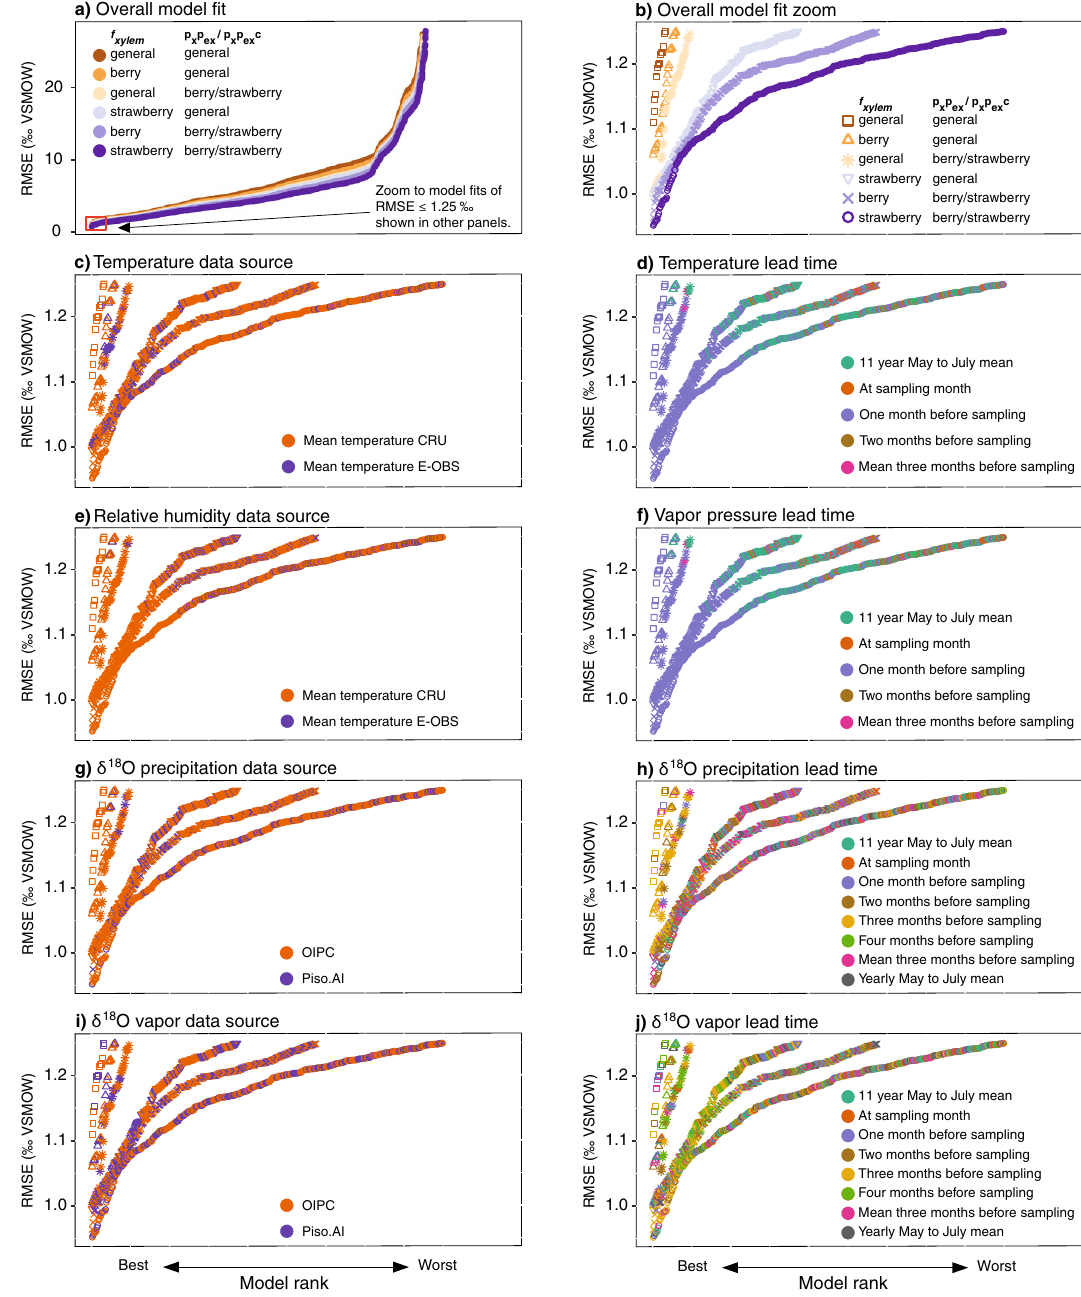
Figure 2. Model fit analysis of all possible parameter and model input data combinations. All panels show model root mean square error (RMSE) values obtained from comparison between modeled and measured bulk dried tissue δ 18 O values (n = 154) from authentic reference samples. Each dot represents the RMSE (in ‰ VSMOW) from one combination of model parameters and input data. RMSE values are ranked by best model fit. Panel ( a ) shows the ranked RMSE values that are lower than 25 ‰ from the total set of 65,536 tested combinations in each of the six differently parameterized models (n ≤ 14,850 for each parameter combination). The symbols are colored according to the different model parameter combinations ( f xylem and p x p ex /p x p ex c) used for the simulations, either general parameters for leaves averaged across various species using literature values (“general”), parameters that are average values for leaves ( f xylem ) and berries (p x p ex c) of berry producing plants (“berry”), or parameters specifically determined for leaves ( f xylem ) and berries (p x p ex c) of strawberry plants (“strawberry”). Panels ( b – j ) only show the models with RMSE values lower than 1.25 ‰ (red square panel a ). Panel ( b ) shows the ranked model fits for the same model parameter and input data combinations as panel ( a ), but introduces symbols for the different model parameter combinations used. These symbols remain the same for panels ( c – j ). In panels ( c – j ) the symbols are colored based on the model input data used for the simulation (see panel in the figures for detail as well as Supplementary Information datasets S1 to S6). Panels ( c ) and ( e ) compare the use of CRU 29 to E-OBS 30 input data, panels ( g ), and ( i ) compare the use of OIPC 31 to Piso.AI 32 isotope data sources, and panels ( d , f , h , j ) compare the use of different lead time intervals leading up to the sampling date of the reference material (see methods). Since the panels only show the best model fits for RMSE values of up to 1.25 ‰, for panels ( d ) and ( f ) some time intervals yielded RMSE values greater than the plotted range, and are thus not indicated in the